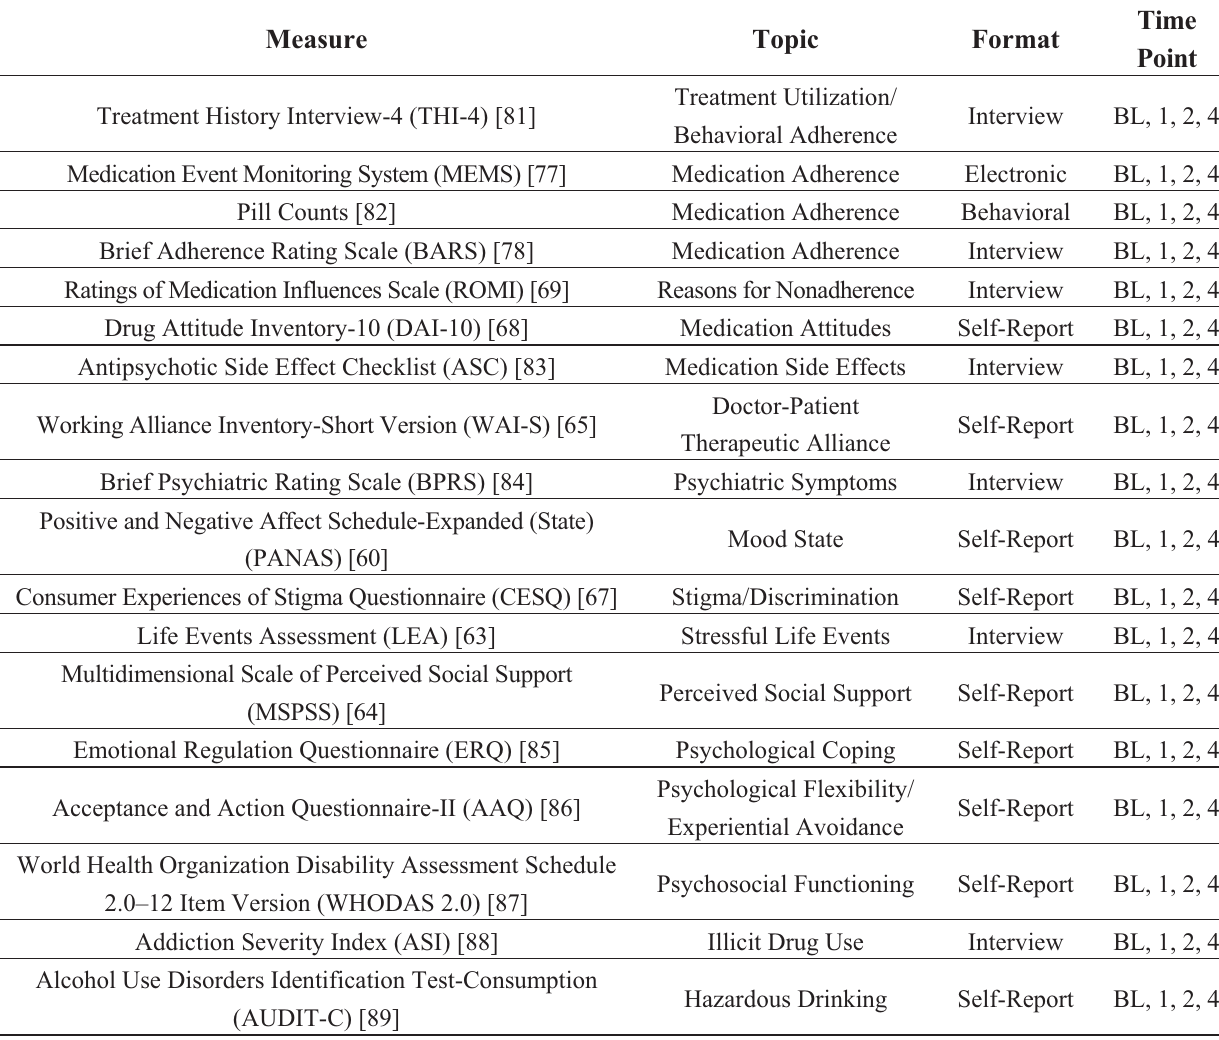
Table 2. Traditional (Non-EMA) Study